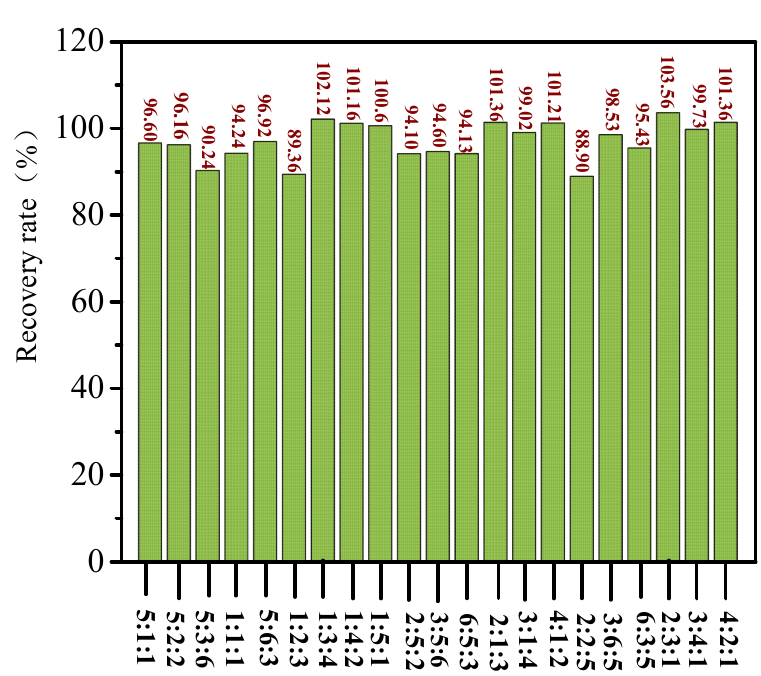
Figure 3. The recovery rate of astaxanthin from P. rhodozyma at different concentration ratios. When the astaxanthin from the three sources was mixed at different ratios, as shown in Table 3, the deviation between the calculated concentration and the actual concentration ranged from 0 to 7 µg/mL, and the recovery rate was between 88.90% and 103.56% (Figure 3). This indicated that the quantitative analysis model of astaxanthin was feasible and reliable, which could be utilized to identify the astaxanthin category and quantify the astaxanthin of each source from different sources and resolve the complicated quantitative problem of the isomers from different sources. This model can not only be applied to the quantitative analysis of astaxanthin but also provide a new pathway for the quantitative analysis of mixtures of other natural products from different sources with each source having different stereoisomer ratios. It should also be noted that the peak areas of astaxanthin in the quantitative analysis model were related to the precision of the method. The analytical range of astaxanthin in the chromatographic column was 5 to 100 µg/mL, so the analytical range of the quantitative model was 5 to 100 µg/mL. 3. Experimental 3.1. Materials and Reagents Synthetic astaxanthin (USP, 100% pure) was purchased from Sigma-Aldrich (St. Louis, MO, USA).Astaxanthin from P. rhodozyma and H. pluvialis were obtained from our laboratory with purities of 100% and 95.6% (calculated by peak area normalization) [24,25], respectively. They were all stored at − 20 ℃ . Hexane, acetonitrile, tert -butyl-methyl-ether, 2-propanol, and methanol were of a chromatographic grade and were purchased from Sigma-Aldrich. Dichloromethane was of an analytical grade (Sinopharm Chemical Reagent Co., Ltd., Shanghai, China). 3.2. Instrumentation Analysis was carried out using an Agilent 1260 infinity quaternary liquid chromatograph (Agilent Technologies Deutschland GmbH, Böblingen, Germany) equipped with an auto injector, an online vacuum degasser, a G1311B/C quaternary pump, a G1329B autosampler, a G1330B